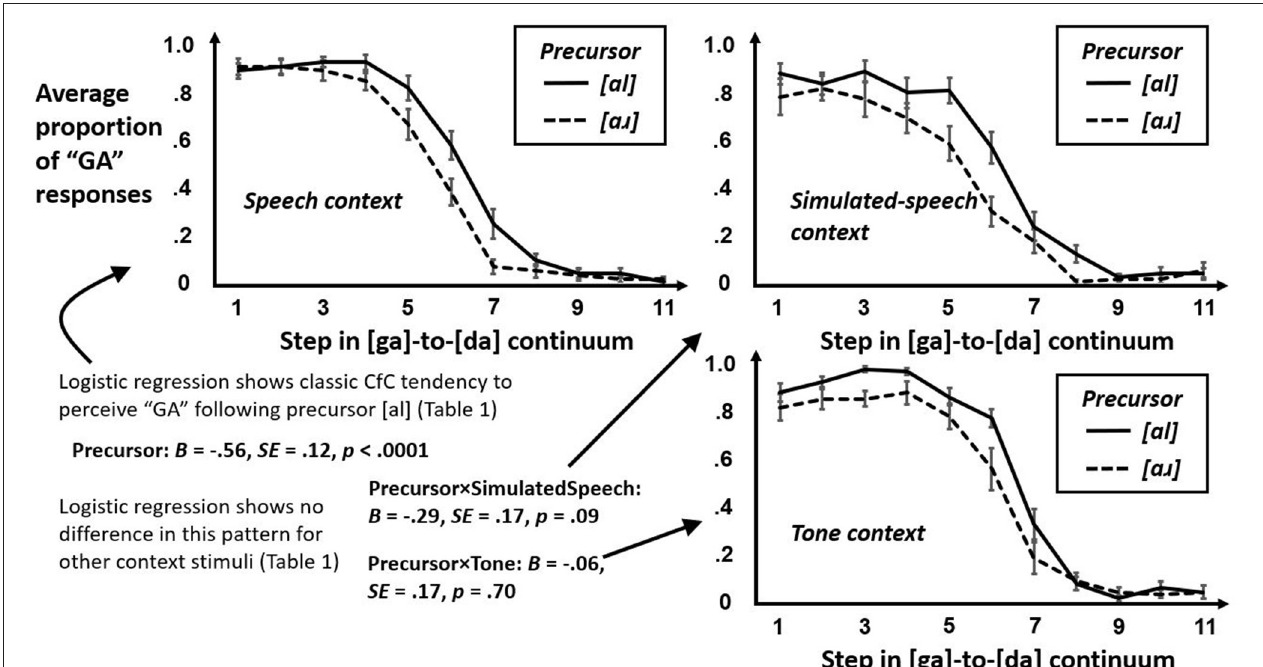
FIGURE 6 | Average proportions of “GA” responses by precursor frequency [al] and [a ô ] plotted across Step in the [ga]-to-[da] continuum, for each of the three conditions in the study: real-speech context (top left panel), simulated-speech context (top right panel), and tone context (bottom right panel). Individual coefficients in the logistic regression in Supplementary Table 1 appear in bottom left panel to reinforce what the resemblance of these plots might already suggest, i.e., that the average proportions of “GA” response due to Precursor is not different following simulated-speech context or tone context than from following real-speech context. The approaching significance (p = 0.09) of the difference due to Precursor in the case of simulated-speech context only reflects an unstable tendency for the average proportions of “GA” response to drop off somewhat sooner for [a ô ] than for [al] from left to right along the Step continuum.